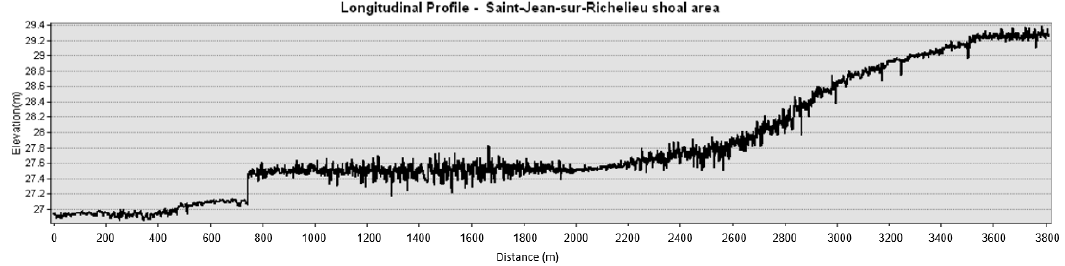
Figure 2. Longitudinal profile from LiDAR data for the Saint-Jean-Sur-Richelieu shoal area.